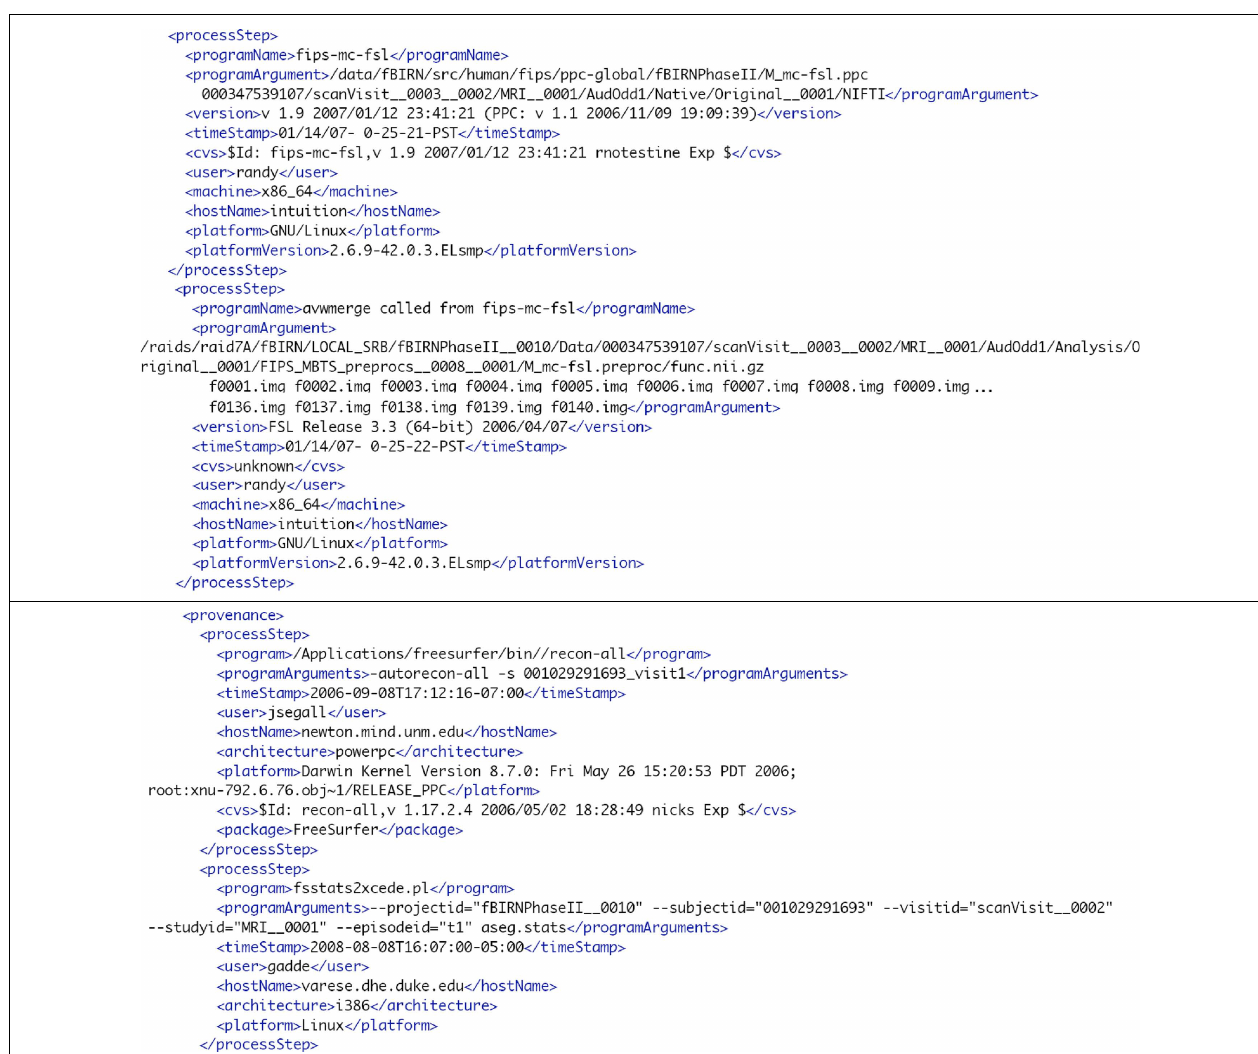
FIGURE 8 | Example XCEDE2 provenance blocks from PreProc (top) analysis and StructMorph (bottom)